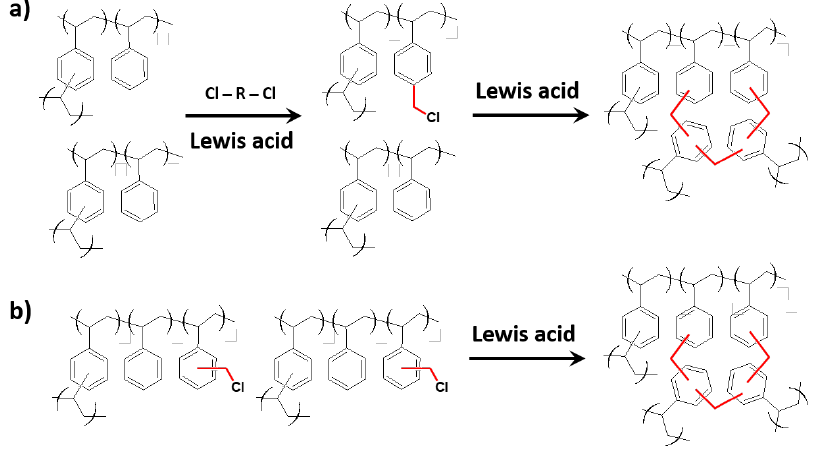
Figure 1. Hyper-crosslinking reaction scheme through external ( a ) and internal ( b ) electrophile.